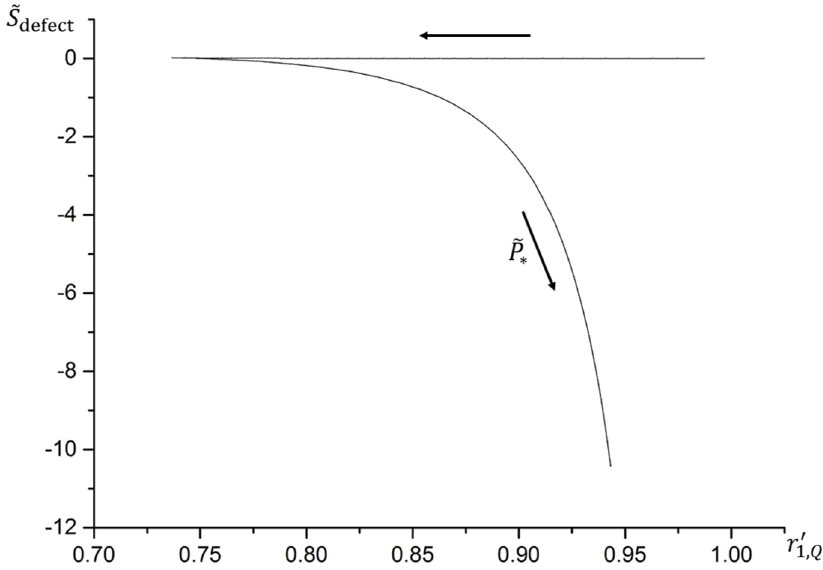
Figure 15 . Plot of defect entropy (5.17) (subtracting the UV divergent terms which does not depend on ˜ P ∗ explicitly) in the unit of πl 3 direction of ˜ P ∗